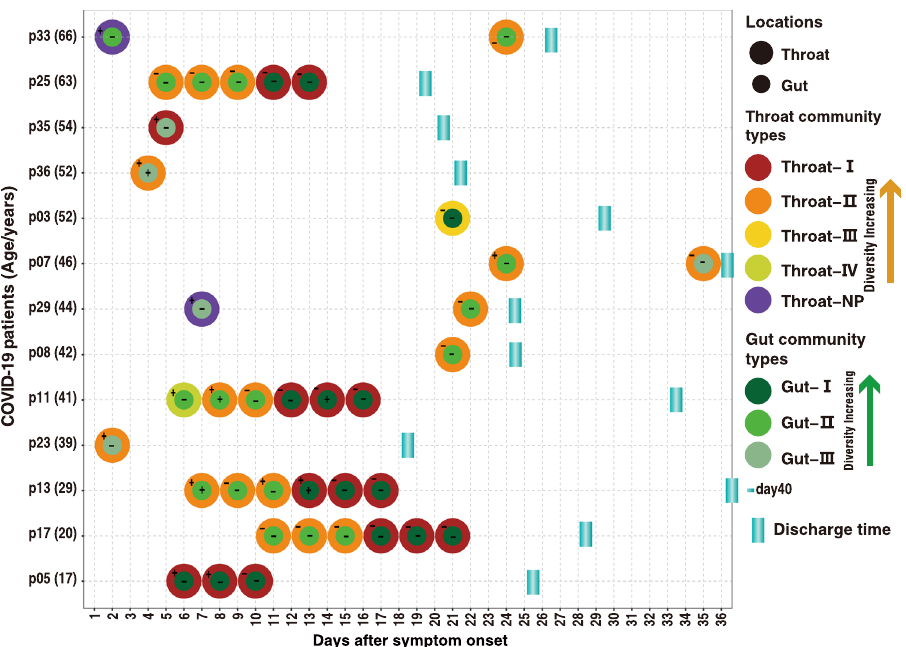
Fig. 3 Dynamic change of bacterial community types (DMM clusters) in respiratory tract and gut of patients with mild COVID-19. Covariation dynamics of throat and gut microbial communities of 13 COVID-19 patients. Filled circles indicate the presence of microbial community types. Positive or Negative detections of SARS – CoV-2 in gut or throat are implicated by + or − symbols, respectively. Age (years) of each COVID-19 adult was shown in